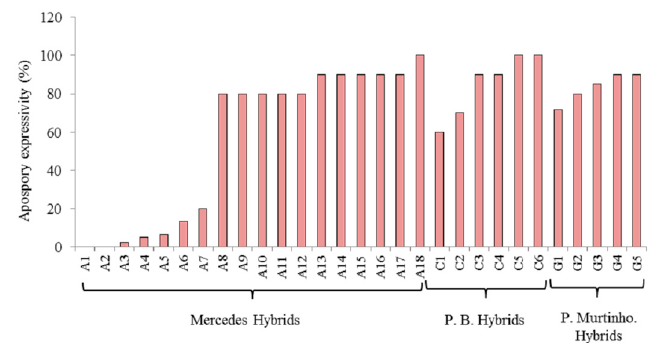
Figure 1. Apomixis expressivity of three families of hybrids of P. simplex analyzed by flow cytometry. P.B: Piedras Blancas hybrids.